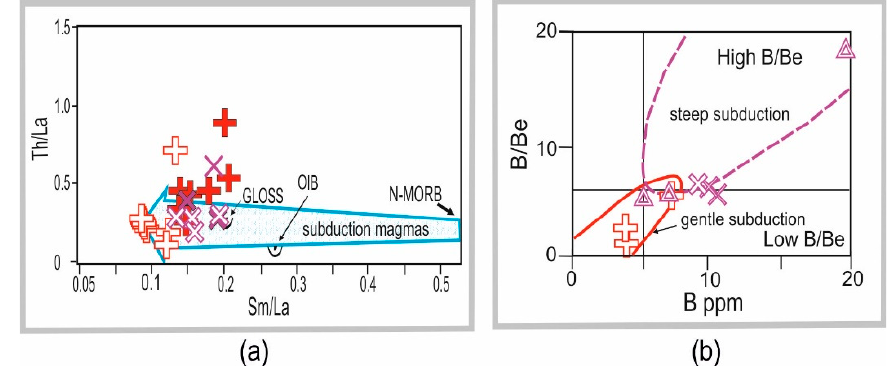
Figure 10. Tectonic interpretation of the EF MOOB framing granitoids based on the taxonomy of the ratio: ( a ) Th/La–Sm/La. Trend of subduction magmas according to [58], OIB and N-MORB values, according to [31], GLOSS-is the average composition of subduction sediments according to [59]; ( b ) B/Be–B according to [60].